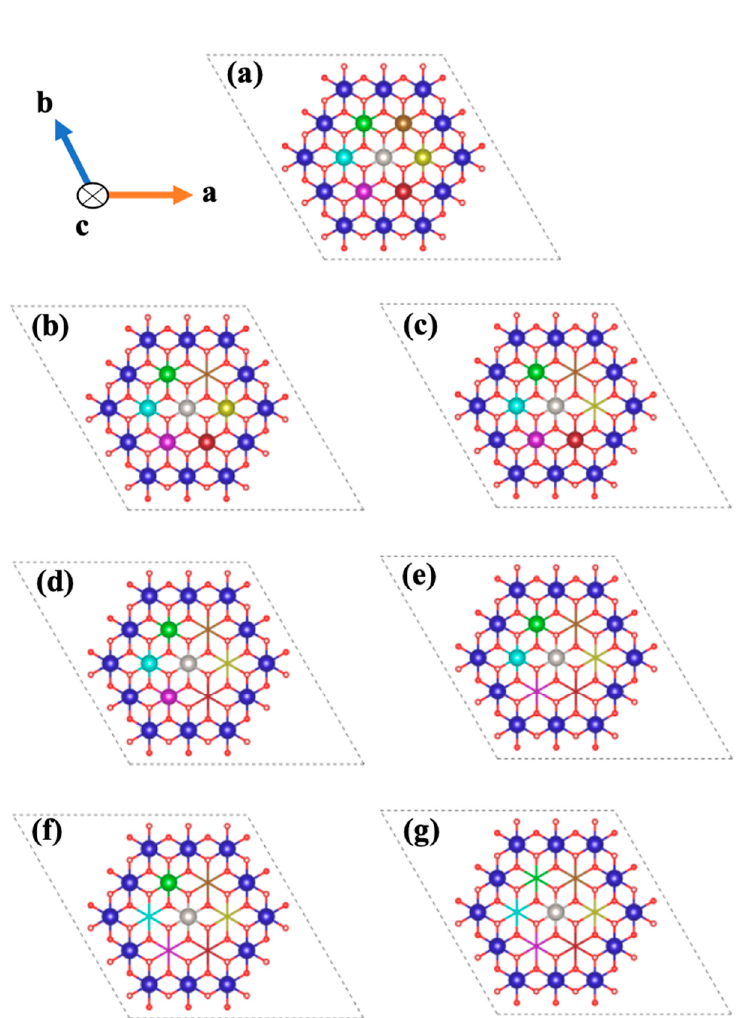
Figure 2. Illustration of seven different scenarios for the central (light gray) Ca atom dissolution depending on the possible significant configurations of existing nearest neighbors (in the presence of all 6 nearest neighbors ( a ), 5 neighbors ( b ), 4 neighbors ( c ), 3 neighbors ( d ), 2 neighbors ( e ), 1 neighbor ( f ), and in the absence of all nearest neighbors ( g )) on the 001 or 00 1 facets of portlandite. Resulting scenarios are proposed to feed the KMC upscaling approach.